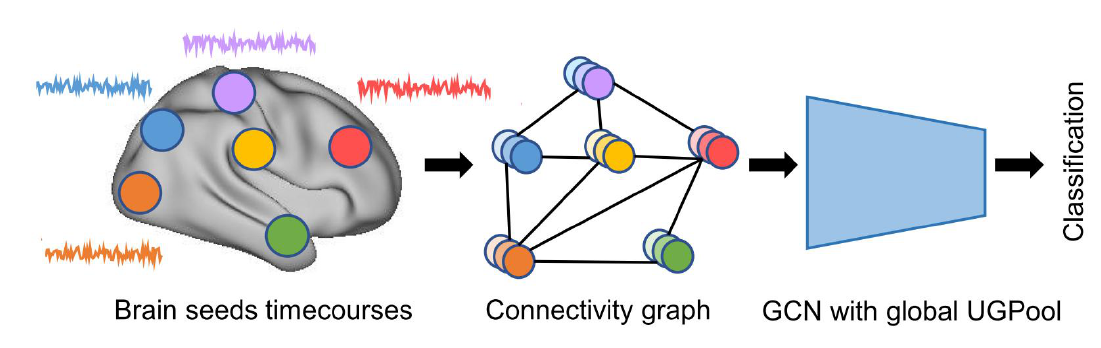
Figure 3. The sample image of fMRI and the illutstrations of our experiments of graph classification.